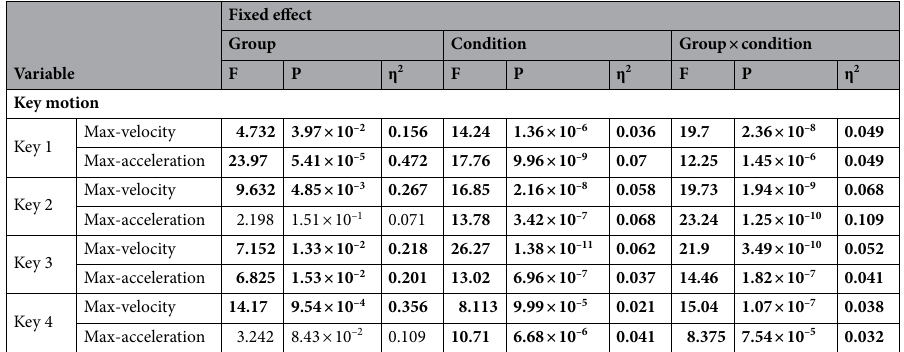
Table 1. Results of two-way mixed-design ANOVA for the maximum velocity and acceleration of the key- motion. Significant values are in bold.